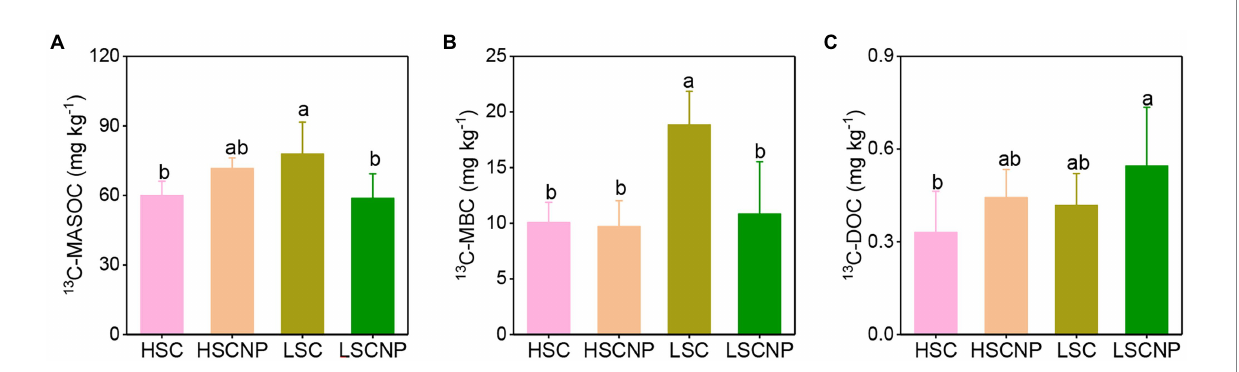
FIGURE 1 13 C-Glucose-derived carbon in the pools of mineral-associated soil organic carbon (MASOC) (A) , microbial biomass carbon (MBC) (B) , and dissolved organic carbon (DOC) (C) after 56 days of incubation. Different letters indicate significant differences ( p < 0.05). HSC, high-salinity soil added with 13 C-glucose; HSCNP, high-salinity soil added with 13 C-glucose and NP nutrients; LSC, low-salinity soil added with 13 C-glucose; LSCNP, low-salinity soil added with 13 C-glucose and NP